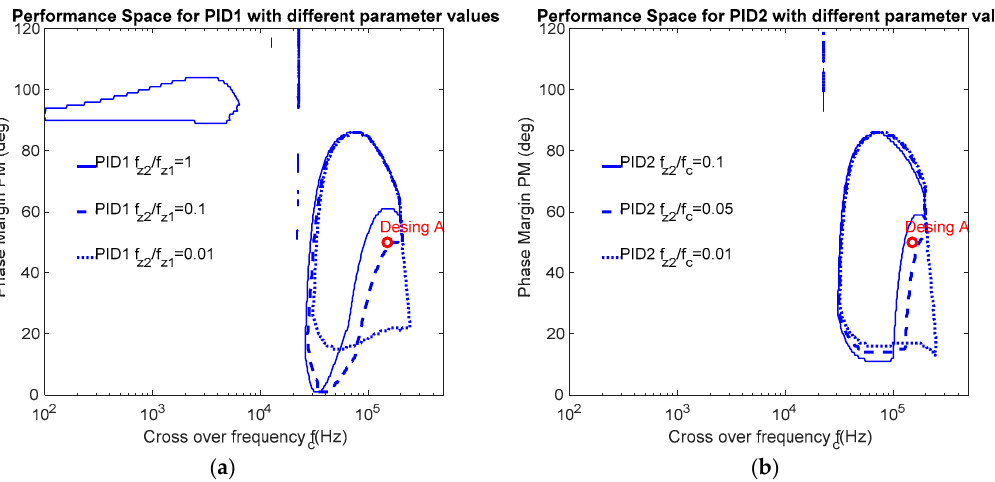
Figure 9. Performance space for the two different PID compensators, considering different values of the design parameter for each of them: ( a ) PID1; ( b ) PID2.